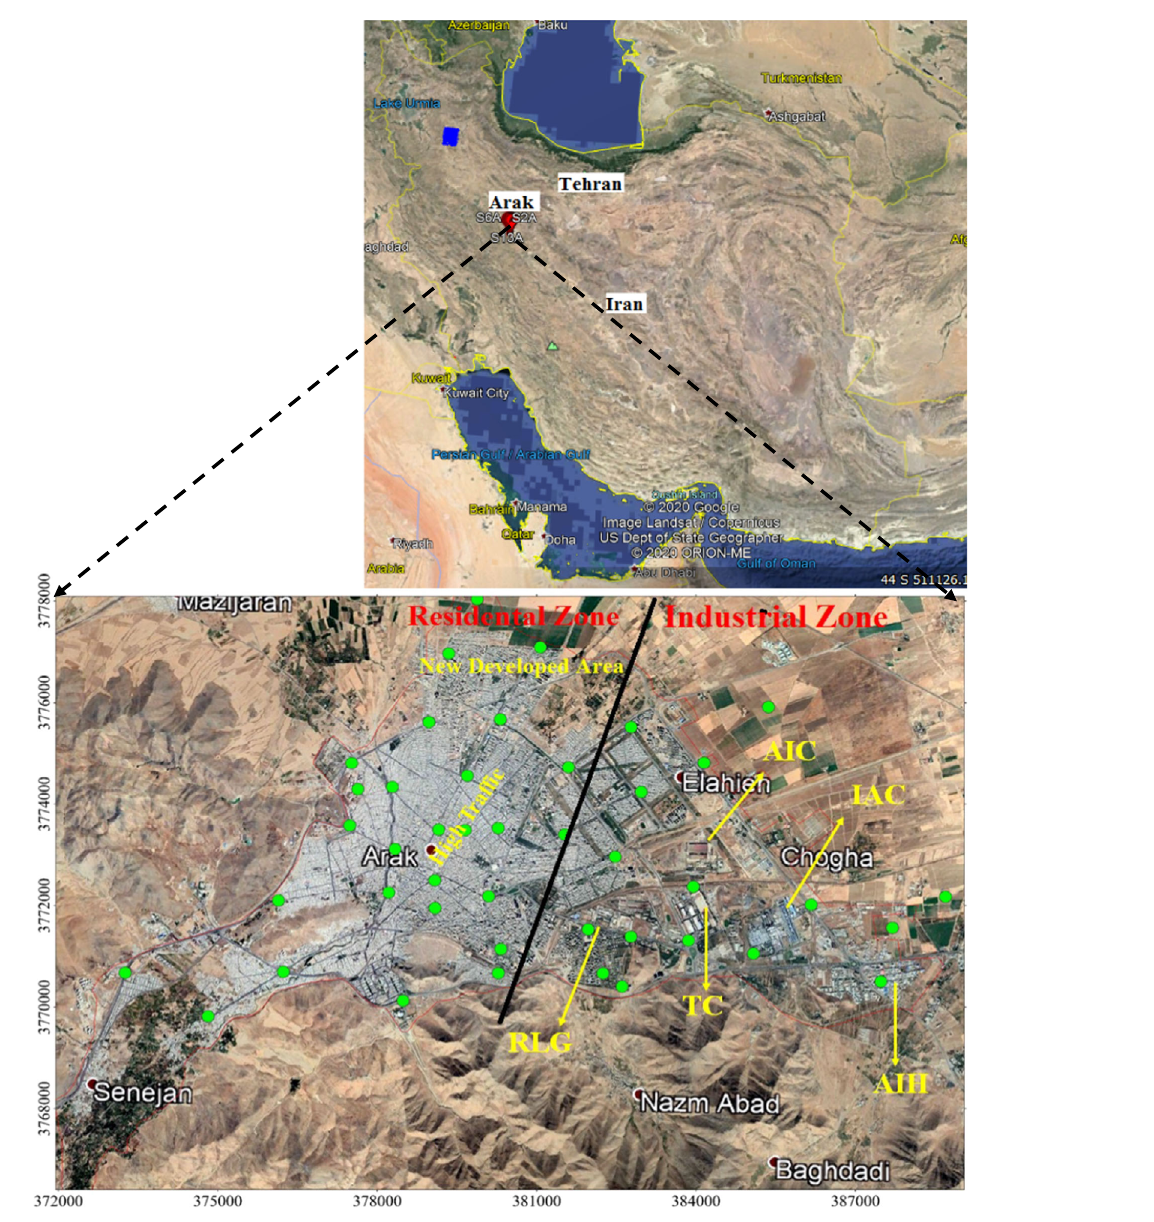
Figure 1. Sampling sites and location of large industries in arak